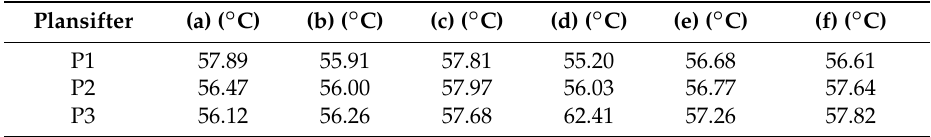
Table 4. Simulated average temperatures at the plansifters for the initial configuration (a) and for the case studies including changes in the position/orientation of the fan heaters